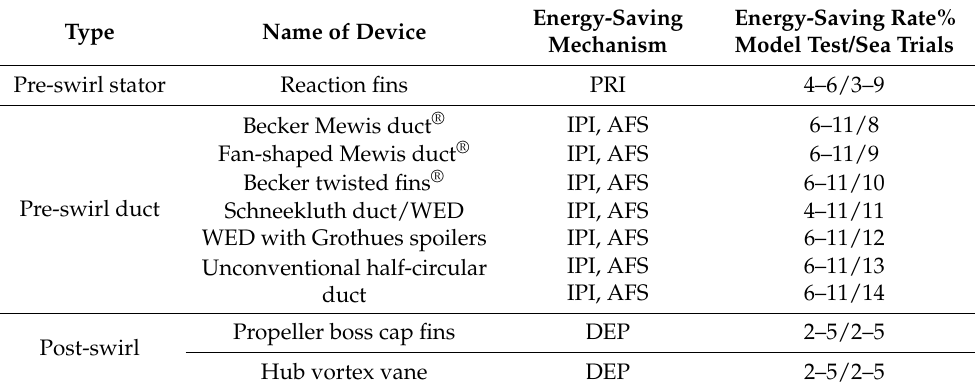
Table 2. Energy-saving devices under analysis (PRI is Pre-Rotation to the propeller Inflow, IPI means Improve Propeller Inflow, AFS means Alleviate Flow Separation, and DEP means Decrease Eddy after Propeller